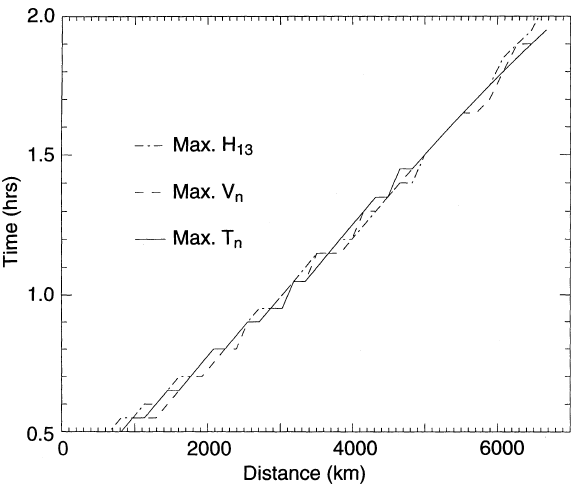
Fig. 7. Time lines for the motion of the disturbances in the height ( dot-dashed line ), temperature ( solid line ) and horizontal velocity ( dashed line ) for the neutral gas on pressure